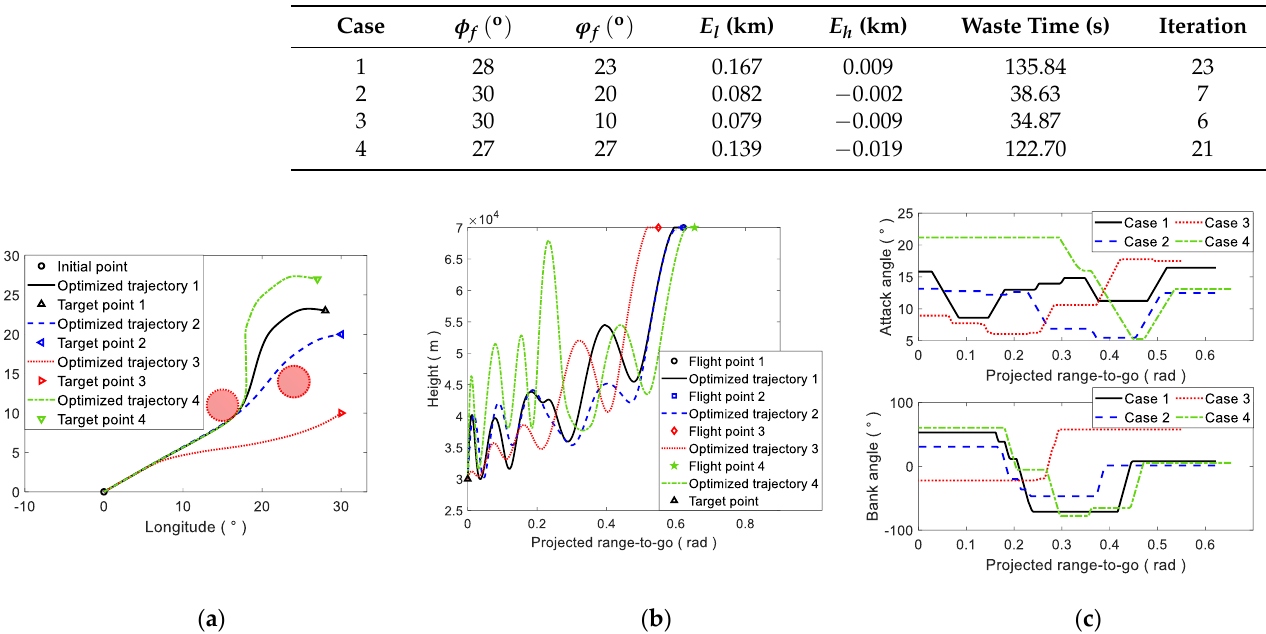
Figure 9. The generation effects of different target points: ( a ) represents the lateral trajectories; ( b ) represents the longitudinal trajectories; ( c ) represents the control angles.